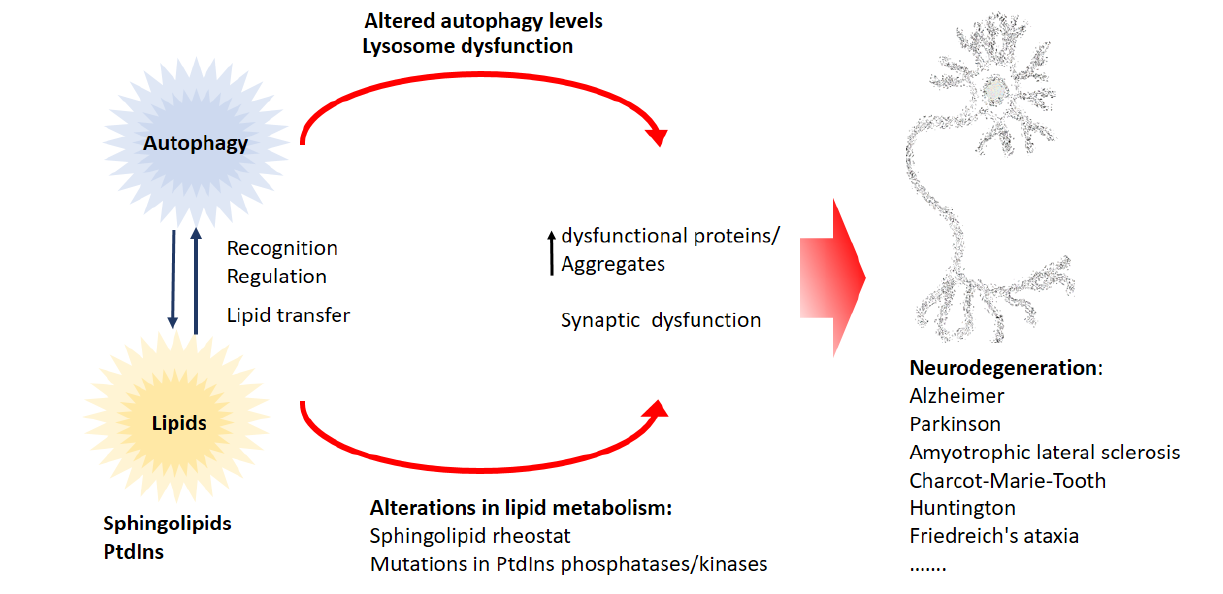
FIGURE 6 : Proposed link of lipids in autophagy and neurodegeneration. There is a tight relationship between lipid metabolism and autoph- agy. Various sphingolipids function as bioactive lipids in the regulation of autophagy, while phosphoinositide phosphates (PtdIns) mainly function in the recruitment of autophagic factors. Autophagy is known to be an essential physiological mechanism to degrade dysfunctional and aggregate-prone proteins that are commonly accumulated in neurodegenerative disease. Changes in the sphingolipid rheostat (imbal- ance in the ratio between the concentrations of the apoptosis activator ceramide, and the anti-apoptotic mediator sphingosine-1- phosphate) have been implicated in many neurodegenerative diseases. Deregulation of phosphatidylinositol levels lead to neurodegenera- tion and various phosphatases and kinases targeting phosphatidylinositols have been found to be mutated in various neurodegenerative